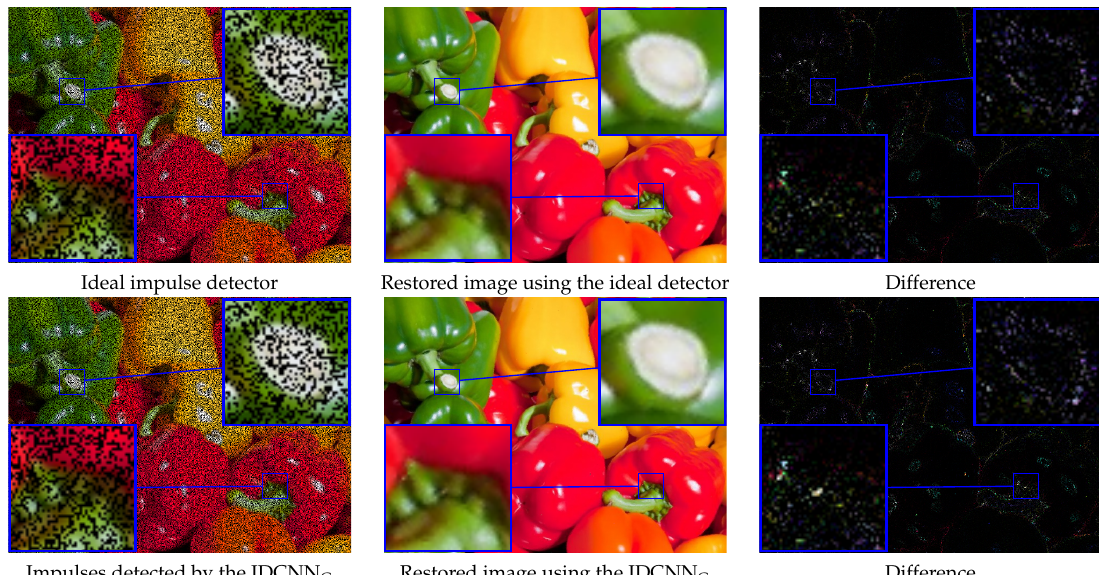
Figure 14. Visualization of the denoising efficiency of the proposed IDCNN G in comparison to the ideal impulse detector, which correctly identifies all impulses in the analyzed image ( ρ = 0.4). The right column shows the difference between the restored and clean